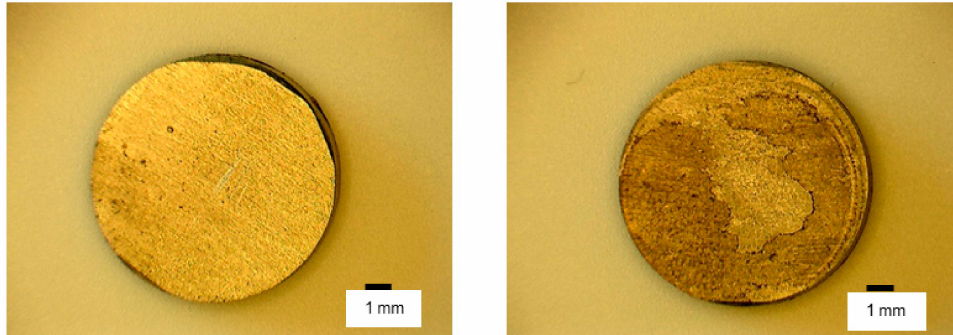
Figure 3. Photos of Ti plates before ( left ) and after ( right ) corrosion of